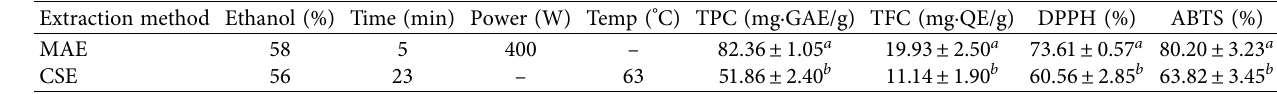
Table 5: Comparison of MAE with CSE.